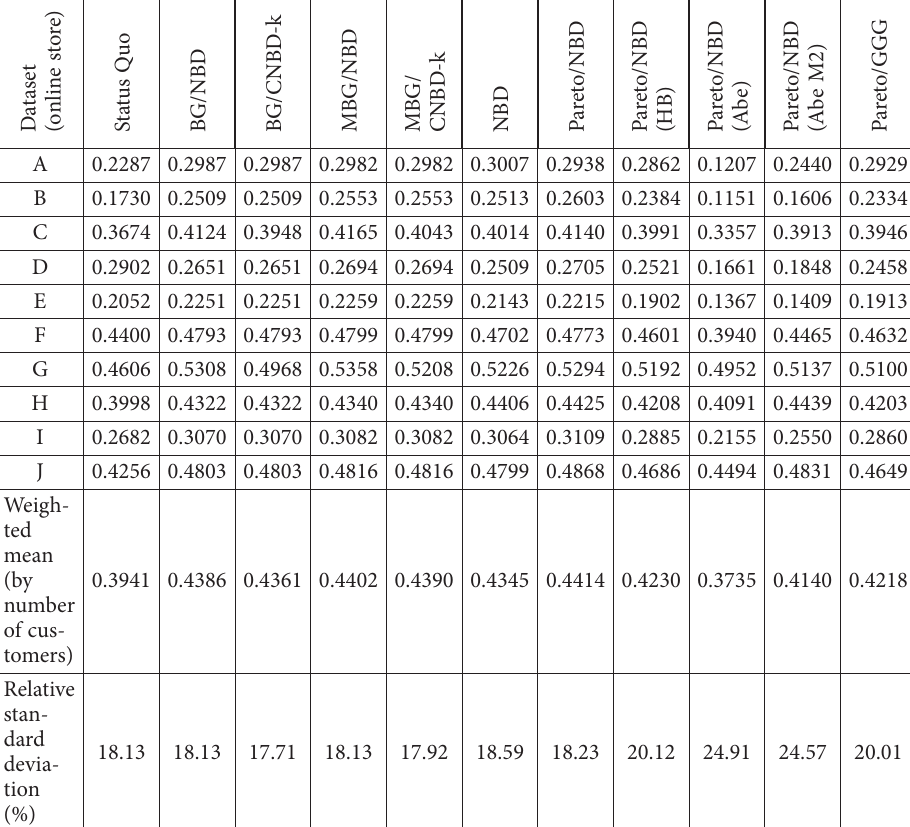
Table 5. Results for Spearman’s rank correlation coefficient